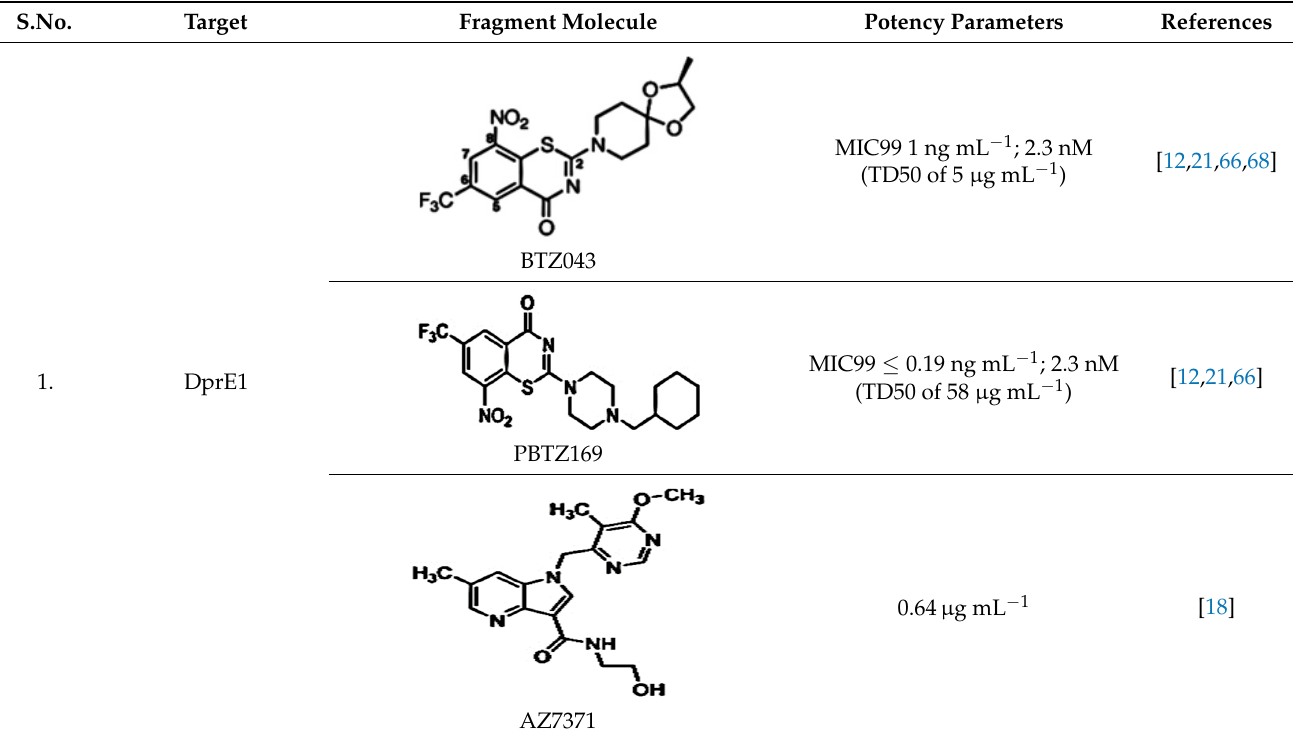
Table 2. TB fragment molecules with potency parameters.